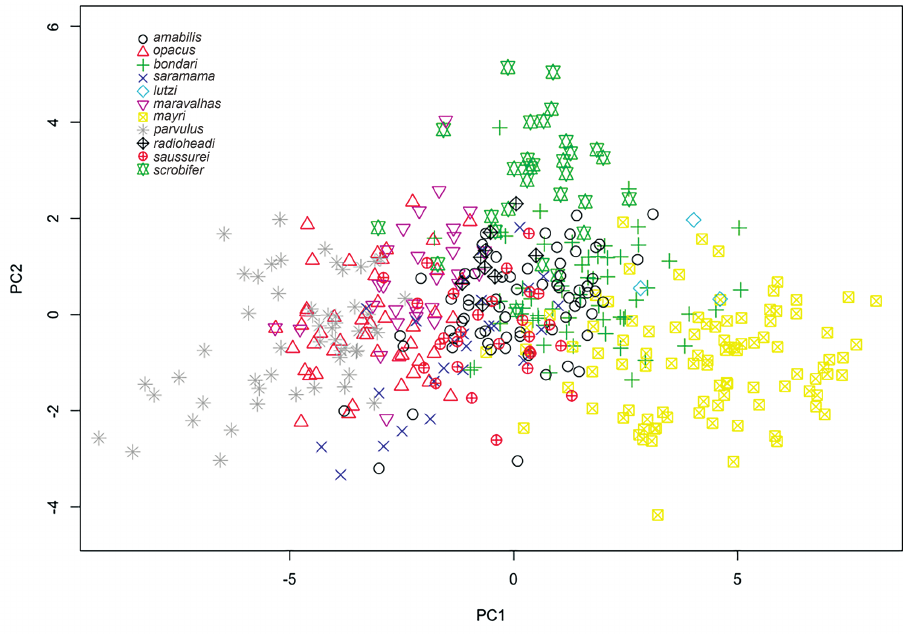
Figure 4. Principal component analysis for all species, scatter